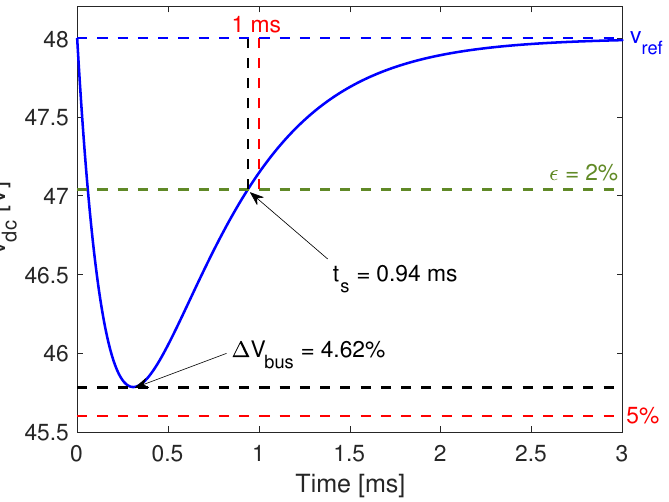
Figure 6. Theoretical response of the bus voltage to 1 A step with α = 0.34 A/V and β = 500 A/V.